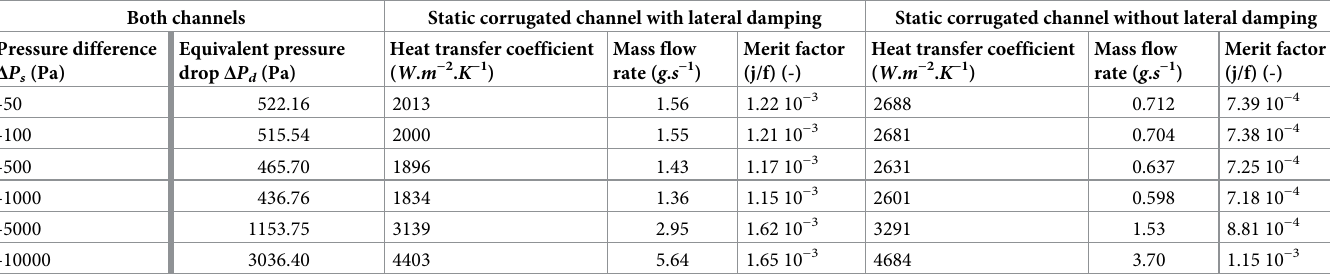
Table 4. Performances of the static corrugated heat exchanger with an amplitude of